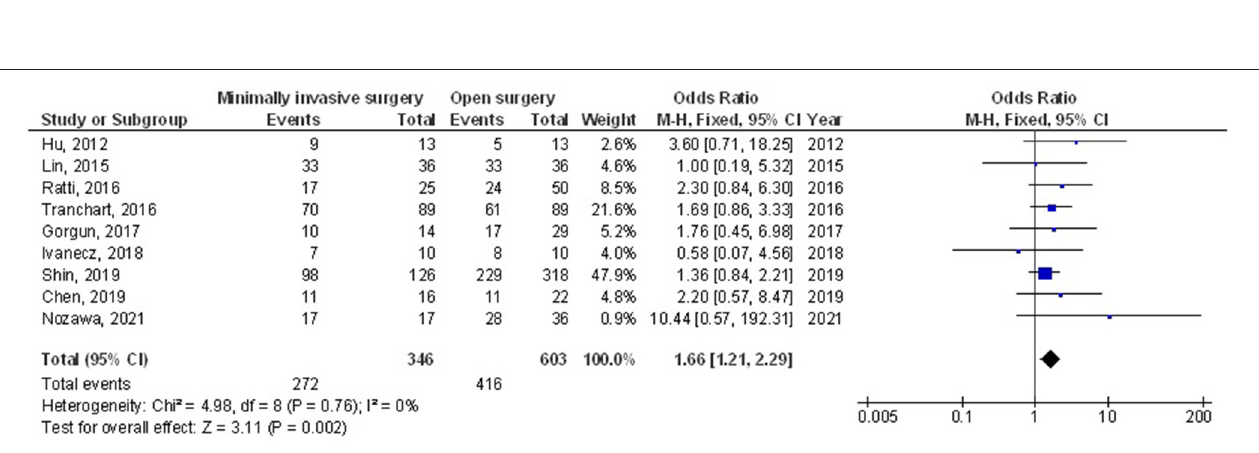
FIGURE 3 | Forest plot of the effect of minimally invasive surgery compared to open surgery on the blood loss in subjects with colorectal cancer and synchronous colorectal liver metastases.